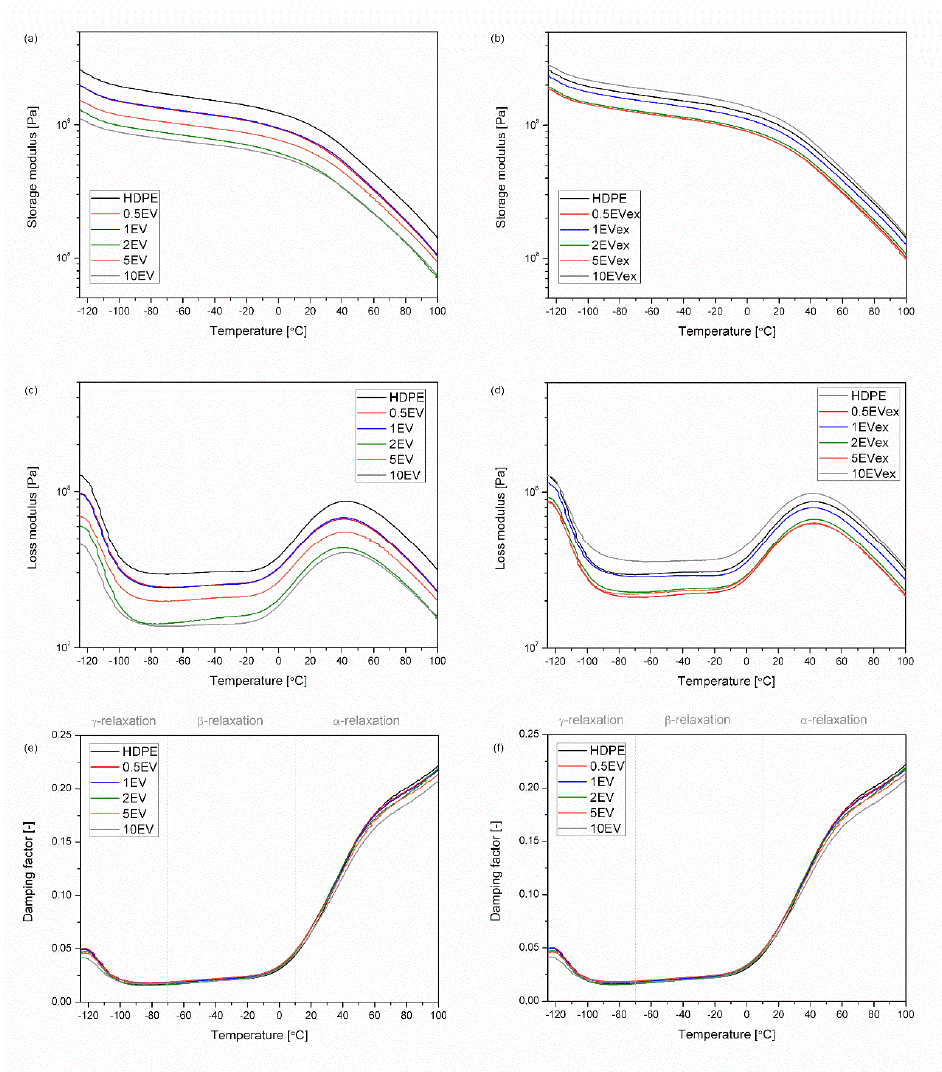
Figure 10. DMA results, storage (G’) ( a , b ), loss (G”) ( c , d ) moduli, and damping factor (tan δ ) ( e , f ) vs. temperature. Table 4. Thermomechanical parameters obtained from DMA data.